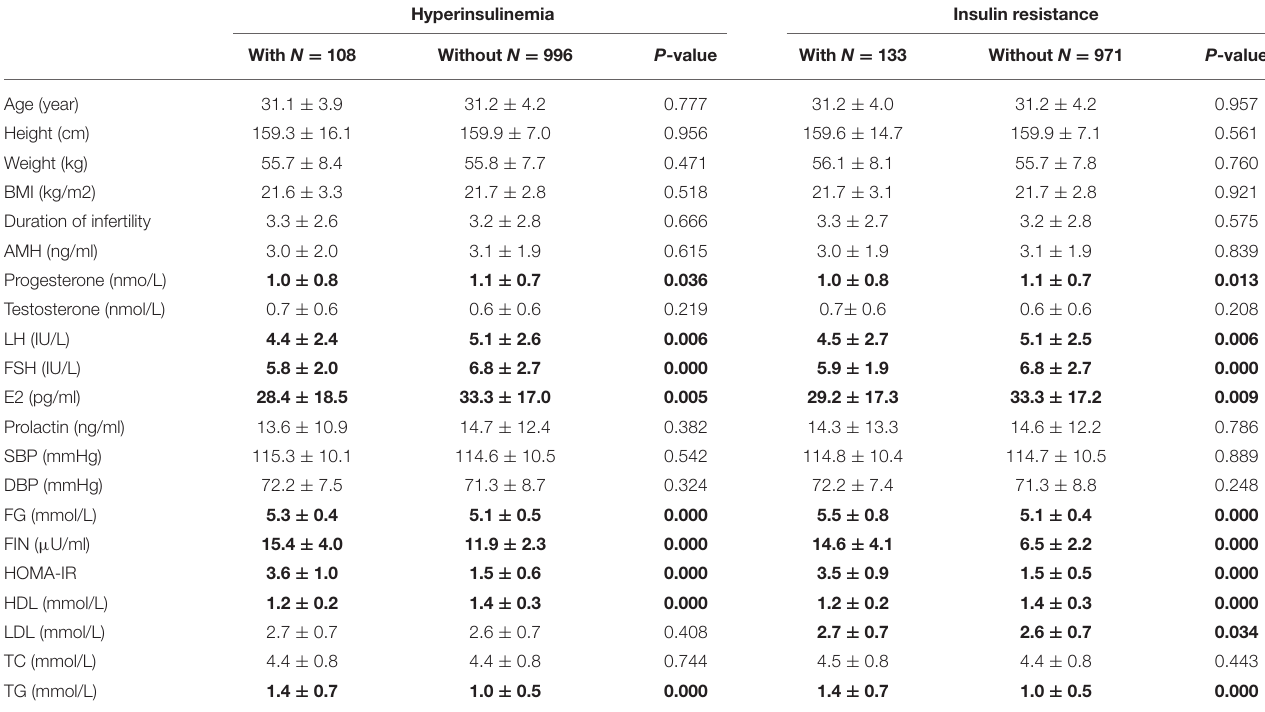
TABLE 3 | Characteristics of women with hyperinsulinemia and insulin resistance.